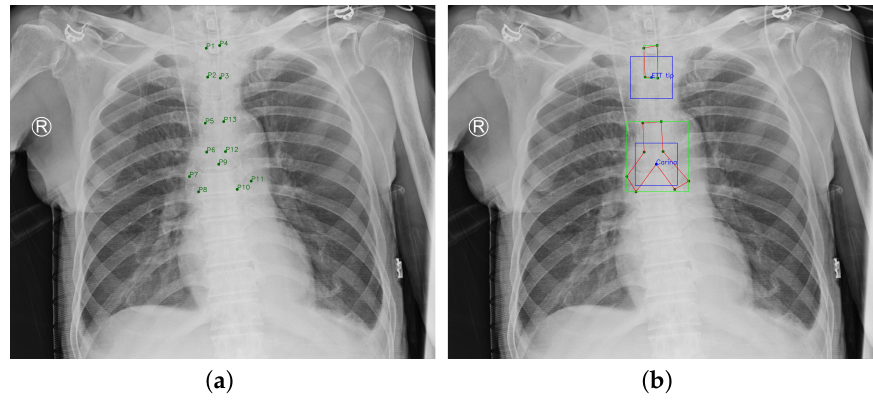
Figure 6. Ground Truth. ( a ) Original ground truth. ( b ) Pre-processed ground